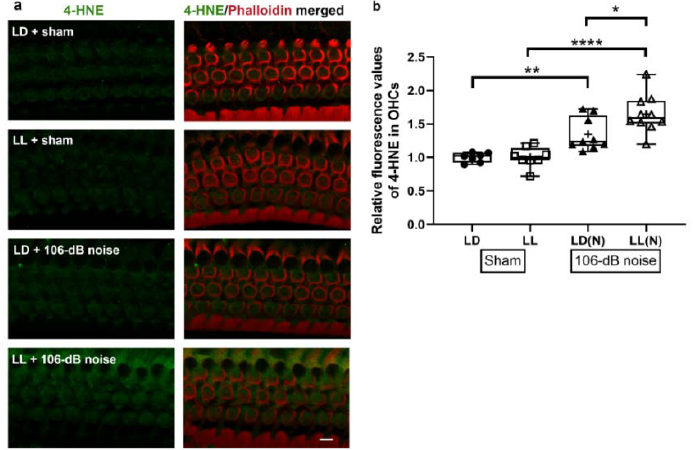
Figure 7. 4-HNE immunolabeling in cochlear surface preparations. ( a ) Representative images of immunoreactivity for 4-HNE in different treatments. Scale bar = 5 µm. ( b ) Quantification of 4-HNE fluorescence in OHCs revealed significantly increased 4-HNE in LD and LL groups after 106 dB noise exposure, while stronger immunolabeling for 4-HNE was observed in the LL(N) group compared to the LD(N) group. Boxplots indicate median and interquartile. + indicates mean value. * p < 0.05, ** p < 0.01, **** p <